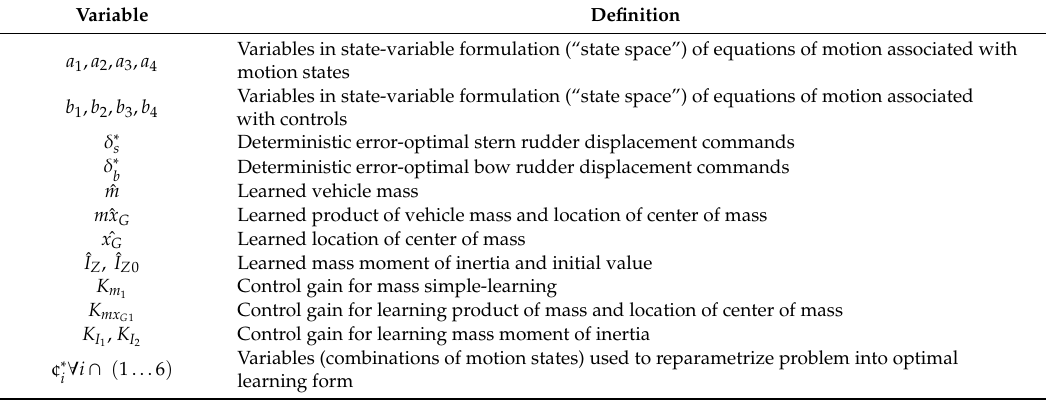
Table 3. Definitions of variables in this part of the manuscript (while a consolidated list is provided in the Appendix